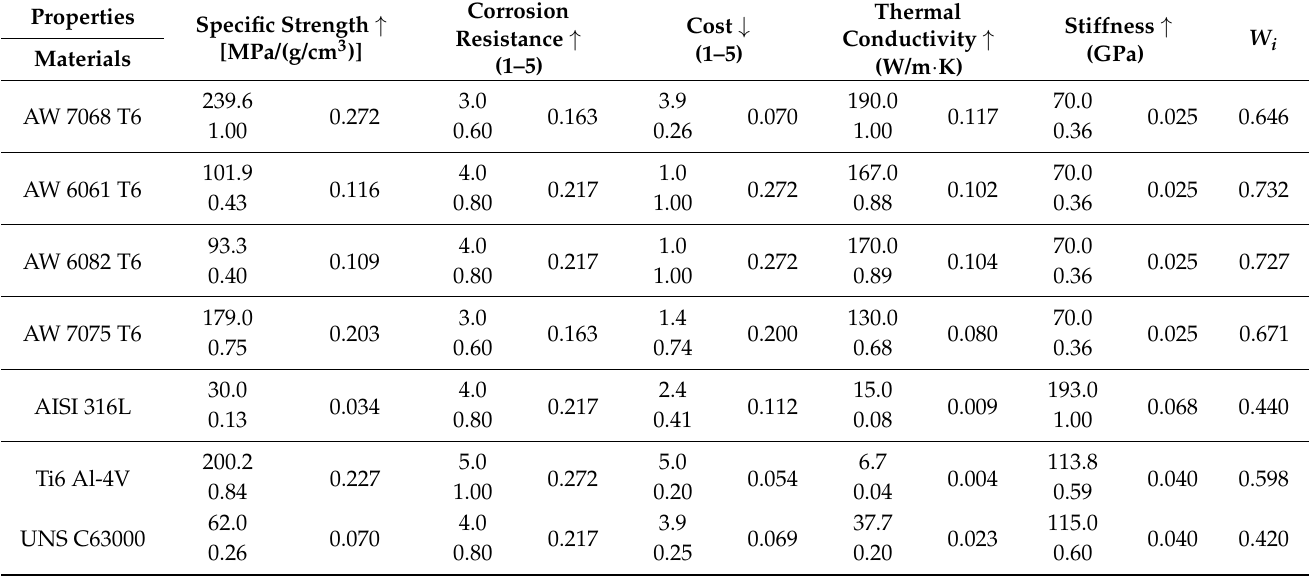
Table 7. Material and weighted index for the lid. Table 7 . Material and weighted index for the lid.